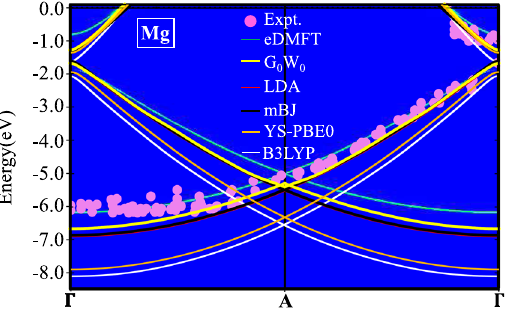
Fig. 3 Band structure of elemental Mg as computed in LDA, mBJ, G 0 W 0 , YS-PBE0, B3LYP, and eDMFT. Pink dots indicate angle- resolved-photoemission (ARPES) data which are adopted from ref. 22 .